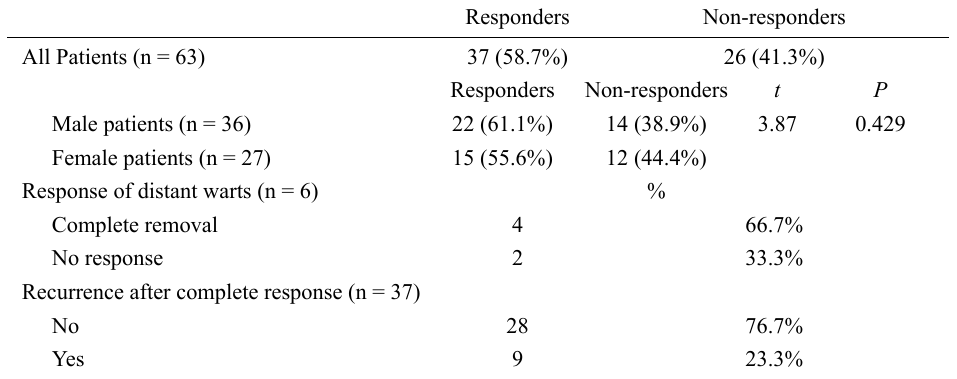
Table 3. Frequency distribution of the studied patients according to clinical response to PPD injection.